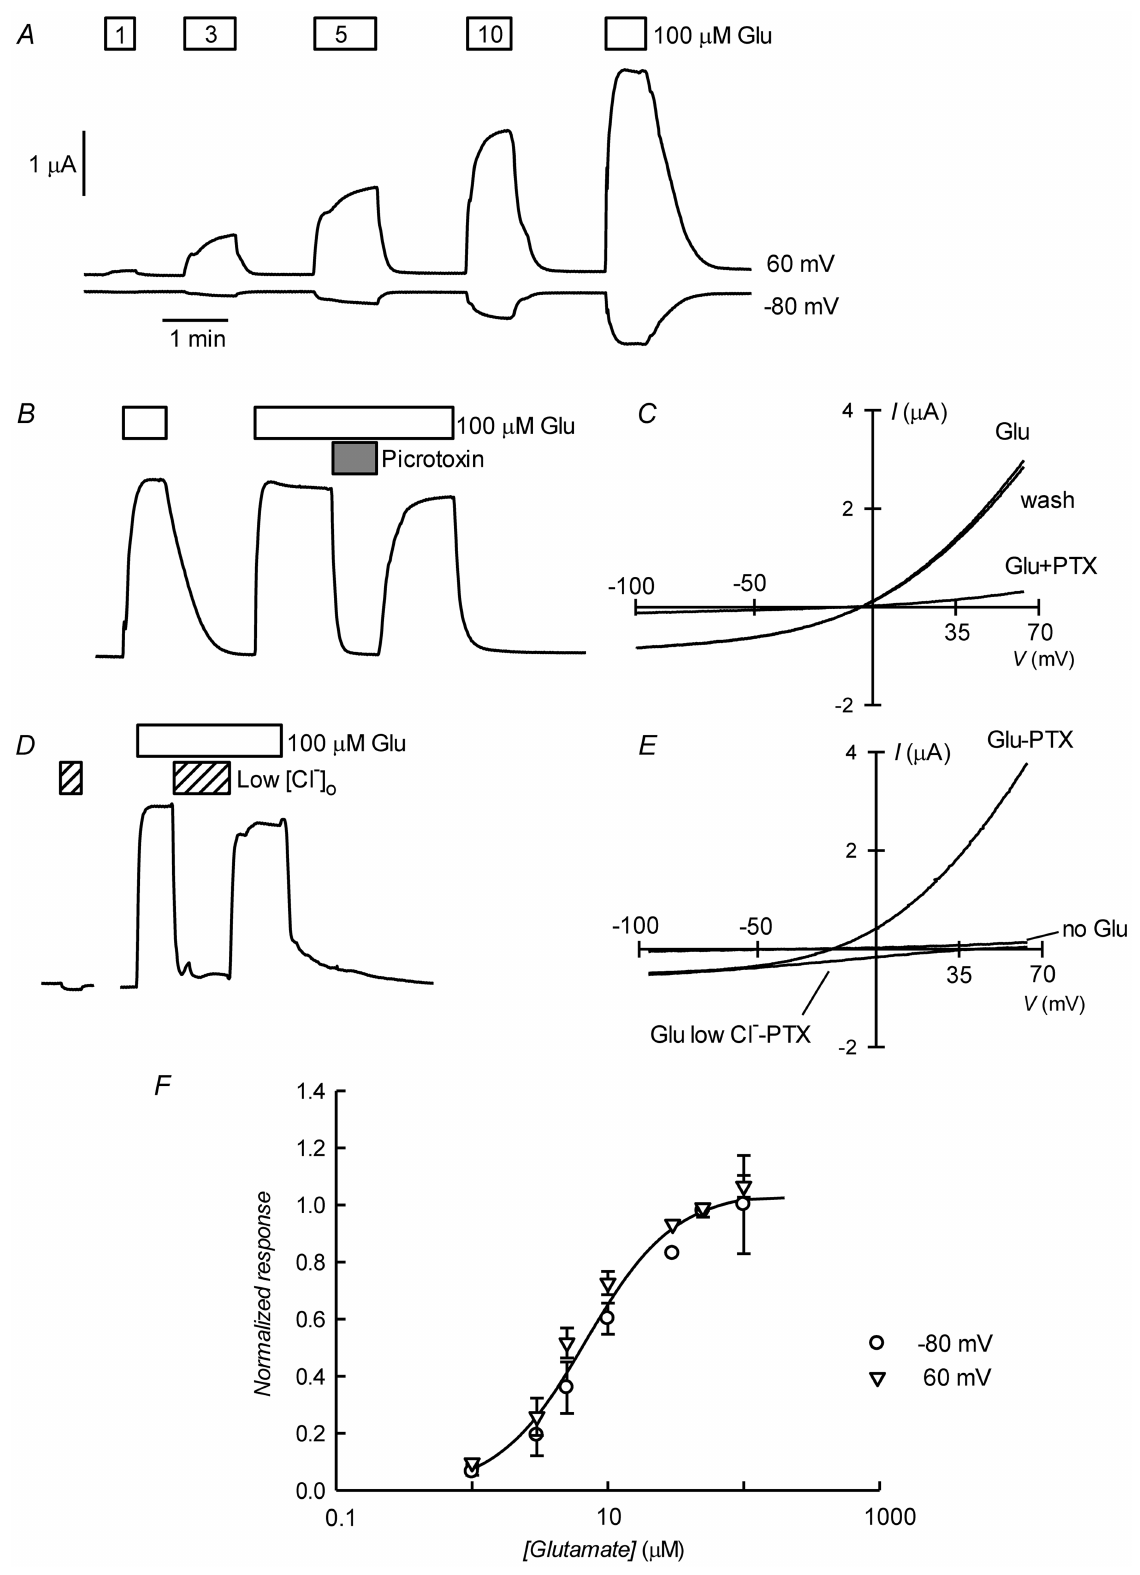
Figure 3. Glutamate-activated picrotoxin-sensitive currents of CrGluCl a RNA-injected Xenopus oocytes. A. Current traces obtained at the indicated membrane potentials during bath application of glutamate at concentrations from 1 to 100 m M during the times shown in the boxes. Current and time calibration bars shown apply also to recordings shown in panels B and D. B. Picrotoxin (PTX) at 100 m M reversibly abolishes glutamate-evoked current. The trace illustrated was taken at 60 mV. Respective current voltage relations taken from voltage-ramps applied during